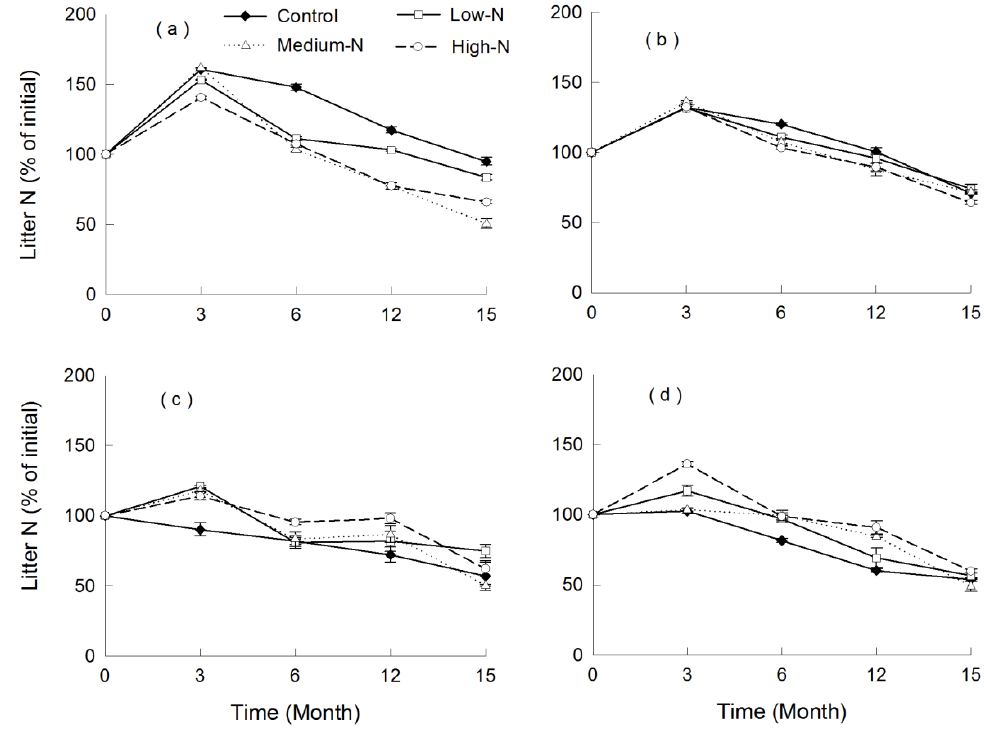
Figure 3. Mean litter nitrogen (N, % of initial) amount with standard error over time in the decomposition of each leaf litter under N addition treatments. ( a ) Chinese pine litter in the plantation; ( b ) Chinese pine litter in the natural forest; ( c ) Mongolian oak litter in the natural forest; and ( d ) Pine-oak litter in the natural forest.